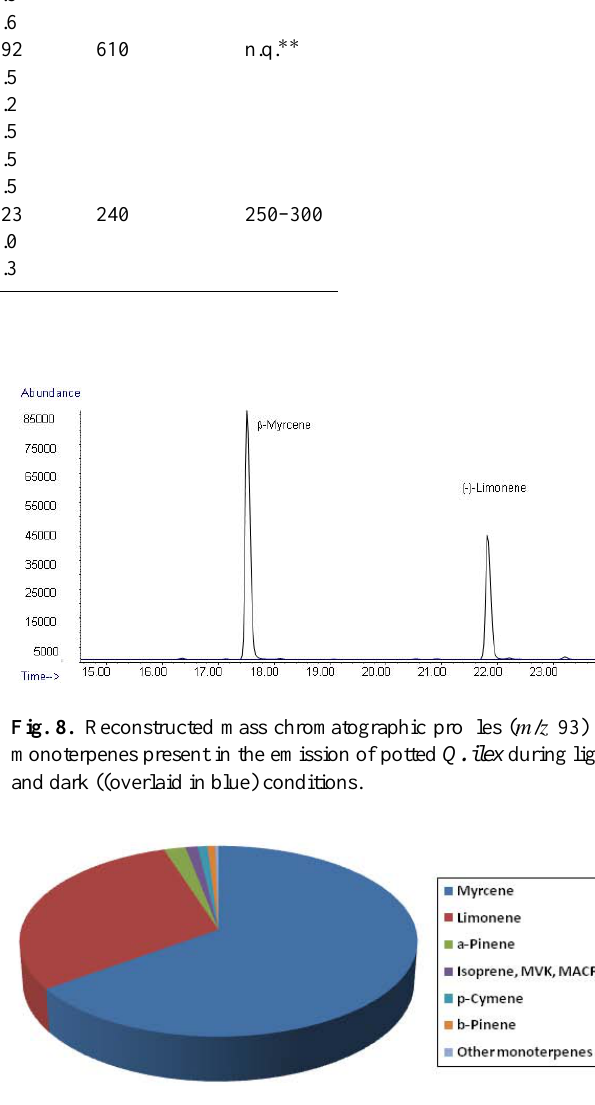
Fig. 9. Composition of monoterpenes emitted by the potted individ- ual of Q. ilex according to solid sorbent GC-FID